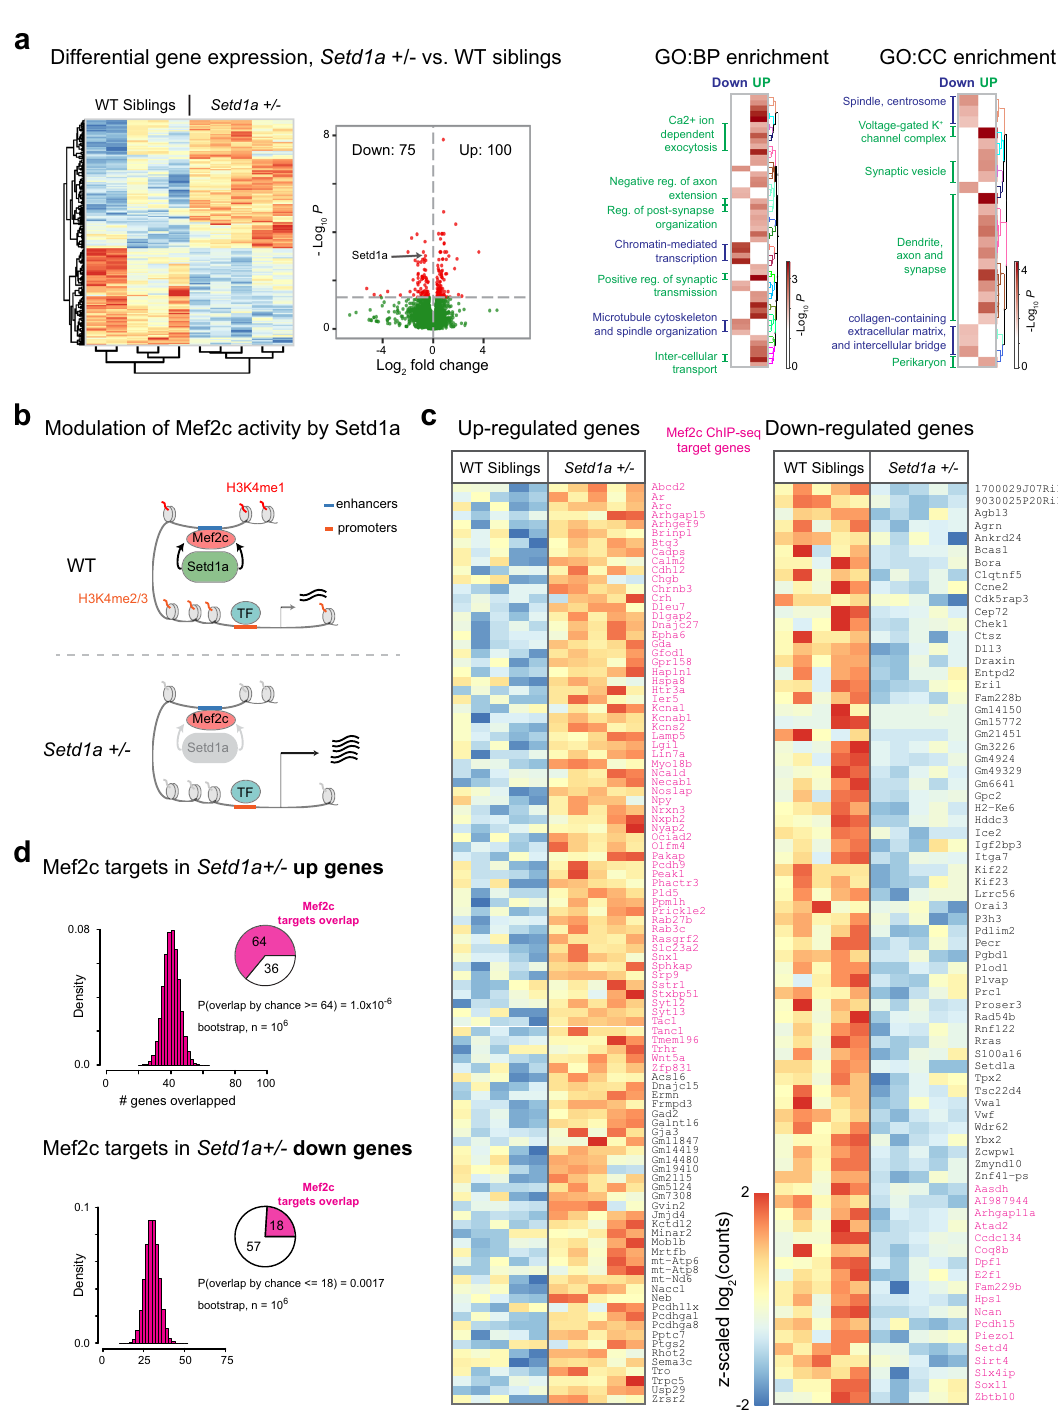
Fig. 6 Characterization of gene expression differences in Setd1a + / − and WT siblings. a Heat map and volcano plot of differential gene expression (DESeq2, padj < 0.05) in Setd1a + / − relative to the WT siblings (DIV 30). Comparative enrichment of Gene Ontology: Biological Process (GO:BP) and Cellular Components (GO:CC) terms is shown for up (green) and down (blue) regulated genes. Also see Supplementary Fig. 12 for complete list. b Schematics summarizing the modulation of Mef2c activity by Setd1a. c Gene expression heat maps are shown for up- and down- regulated genes. Magenta-colored genes are also known targets from Mef2c ChIP-seq studies. d Bootstrap sampling (10 6 ) for estimating statistical signi fi cance of overlap with Mef2c targets by chance. P-values are uncorrected probabilities as de fi ned in the panel. All sample replicates are biological. dependent transcription. To test this hypothesis, we compared the neuropeptide and neurohormone. This upregulation of synapse set of genes targeted by Mef2c, as identi fi ed by ChIP-seq genes may be due to the known role of Setd1a as modulator of experiments 24 , with upregulated and downregulated genes in Mef2c (Fig. 6b) 24 , which is a known activity-dependent transcrip- tional activator of synaptic genes during development 24,48 . The Setd1a + / − MoNNets. Remarkably, we found 64 out of 100 reduction in Setd1a expression level may lead to higher Mef2c- upregulated genes in Setd1a + / − to overlap with known Mef2c NATURE COMMUNICATIONS| (2022) 13:3340